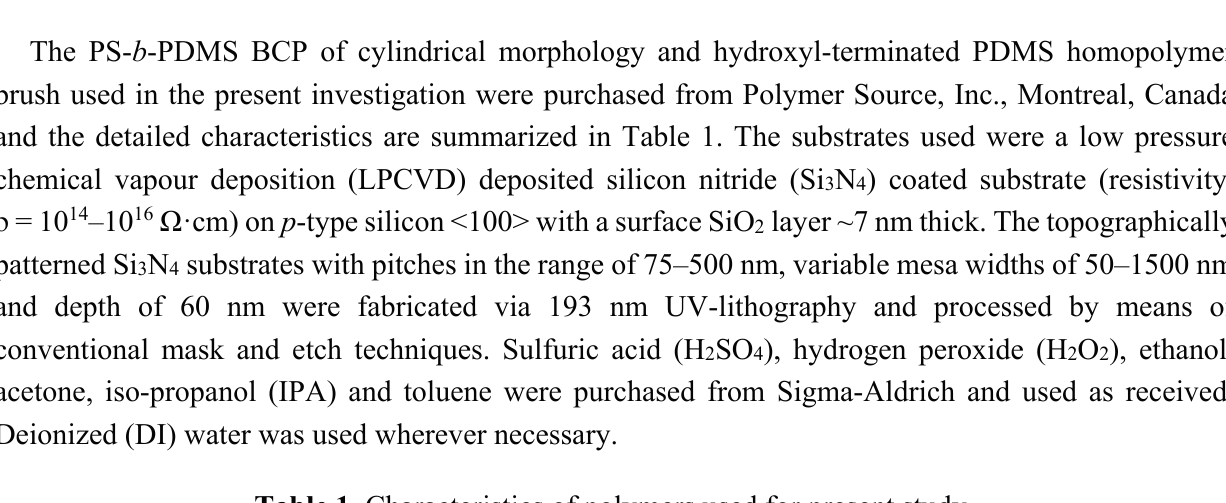
Table 1. Characteristics of polymers used for present